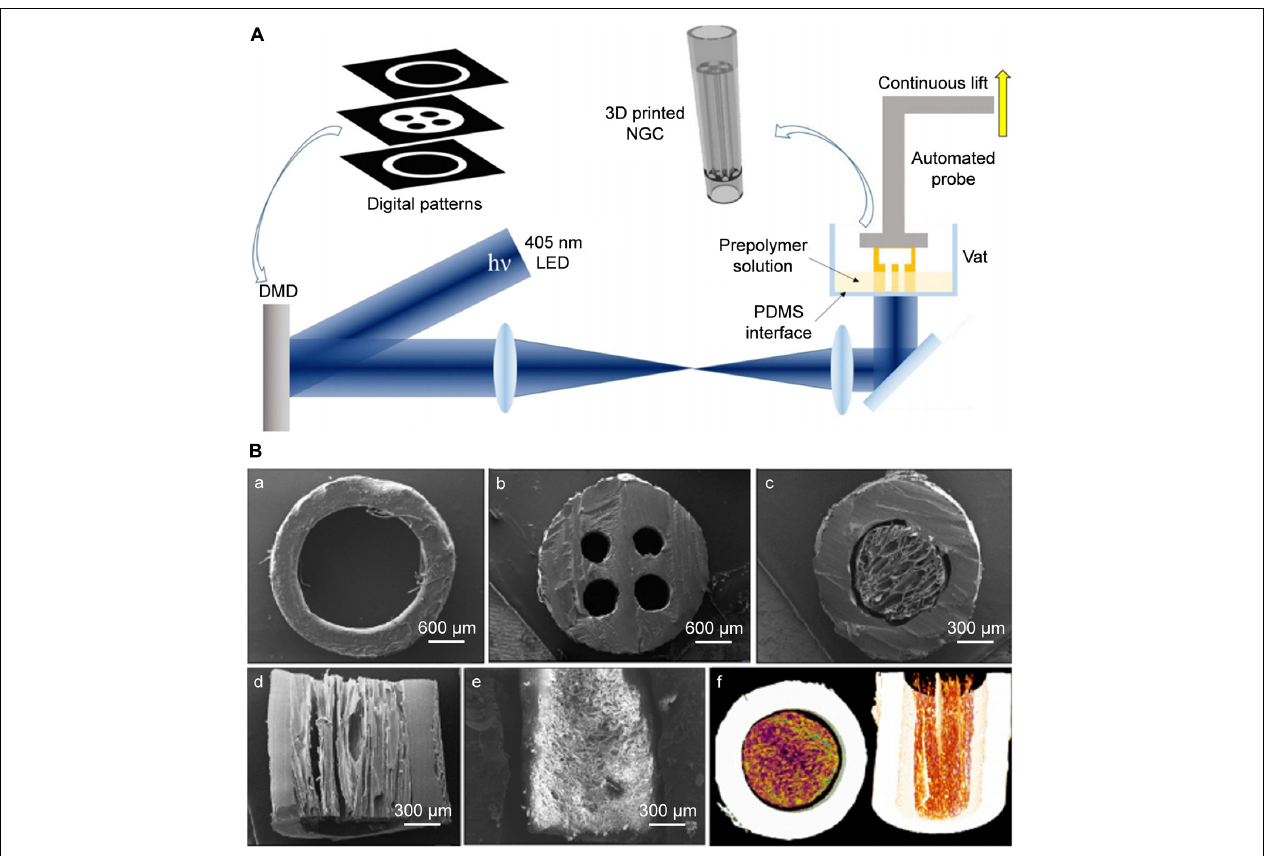
FIGURE 3 | Rapid continuous 3D printing. (A) Schematic diagram of the rapid continuous 3D printing (Zhu et al., 2018). (B) SEM images of complex structured NGCs transverse sections of hollow (a) , 4-multichannel (b) , aligned cryomatrix-filled NGC (c,d) , random cryomatrix-filled (e) , Micro-CT image of aligned cryomatrix-filled NGC (f) (Singh et al., 2018). (A) Reproduced with permission from Zhu et al. (2018) and (B) Reproduced with permission from Singh et al. (2018).